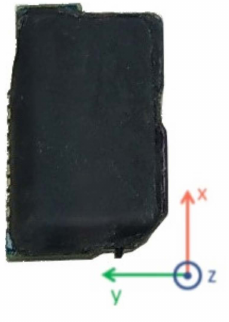
Figure 5. Custom Wearables right-handed coordinate